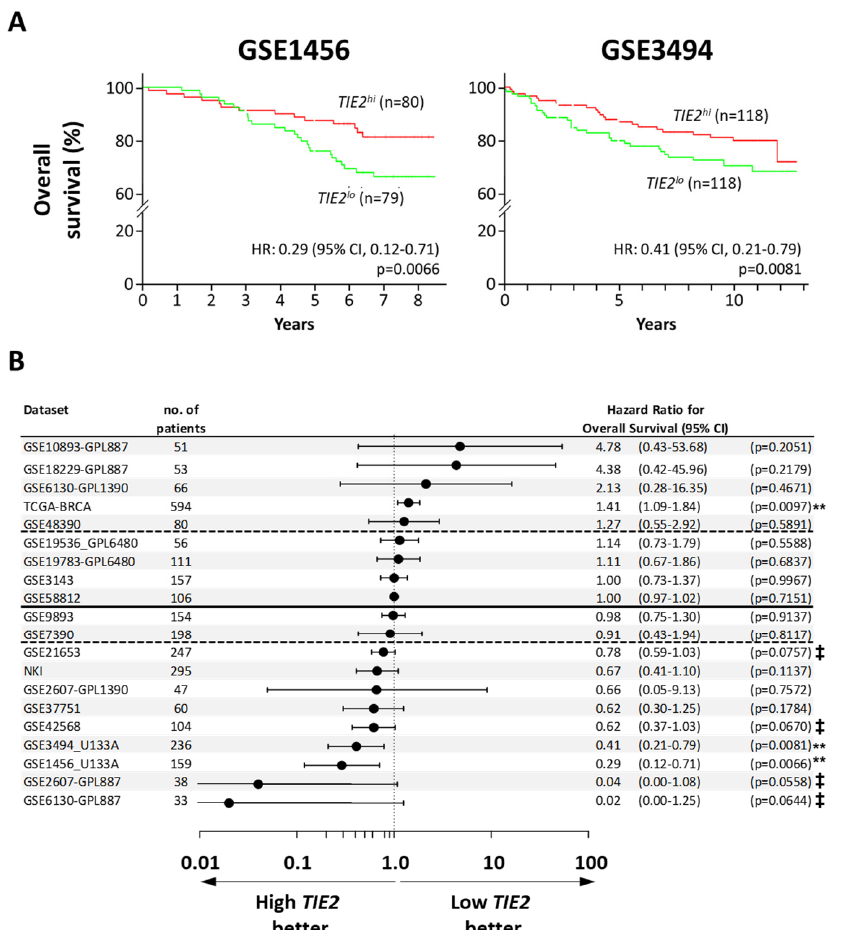
Figure 2. High expression of TIE2 in the primary tumor of breast cancer patients is associated with increased overall survival. Analysis of overall survival using the PROGgene database. The median TIE2 mRNA level in the primary tumor was taken as a bifurcation point. Results are presented as ( A ) Kaplan–Meyer plots for the Pawitan (GSE1456) and Miller datasets (GSE3494), or as ( B ) a forest plot, indicating the overall hazard ratio (HR) for metastasis-occurrence and 95% confidence interval (CI). The horizontal line divides datasets with a HR higher or lower than 1, the dotted lines separate the datasets with a HR lower than 0.85 and higher than 1.15. Survival analysis was performed using a log-rank test, ‡ p < 0.078, and ** p < 0.01.